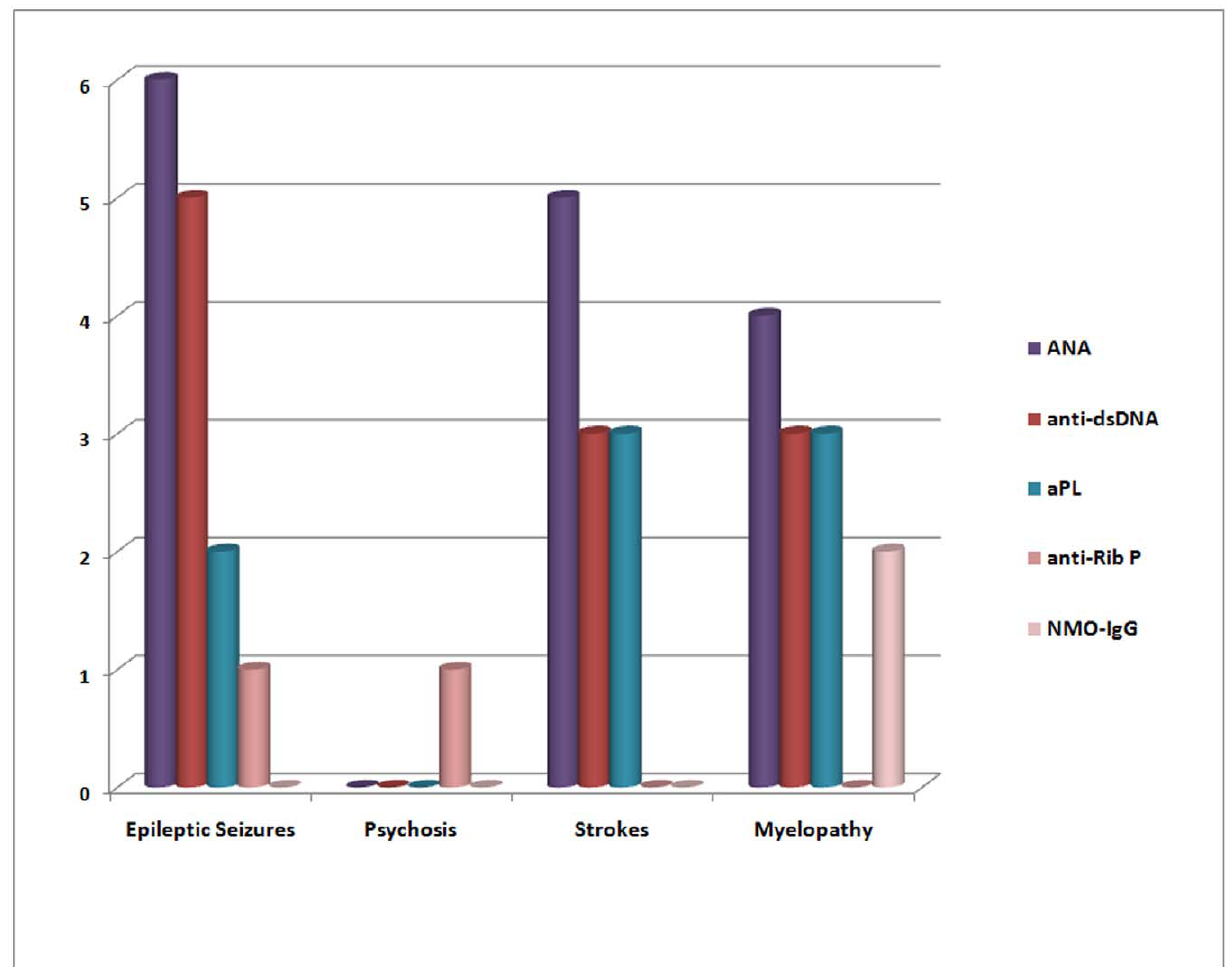
Figure 1. Numbers of patients with the respective antibodies within each CNS subgroup. Each column group refers to the respective CNS subgroup. Each column represents a discrete autoantibody, while Y axes displays the number of patients presenting with the respective autoantibody.